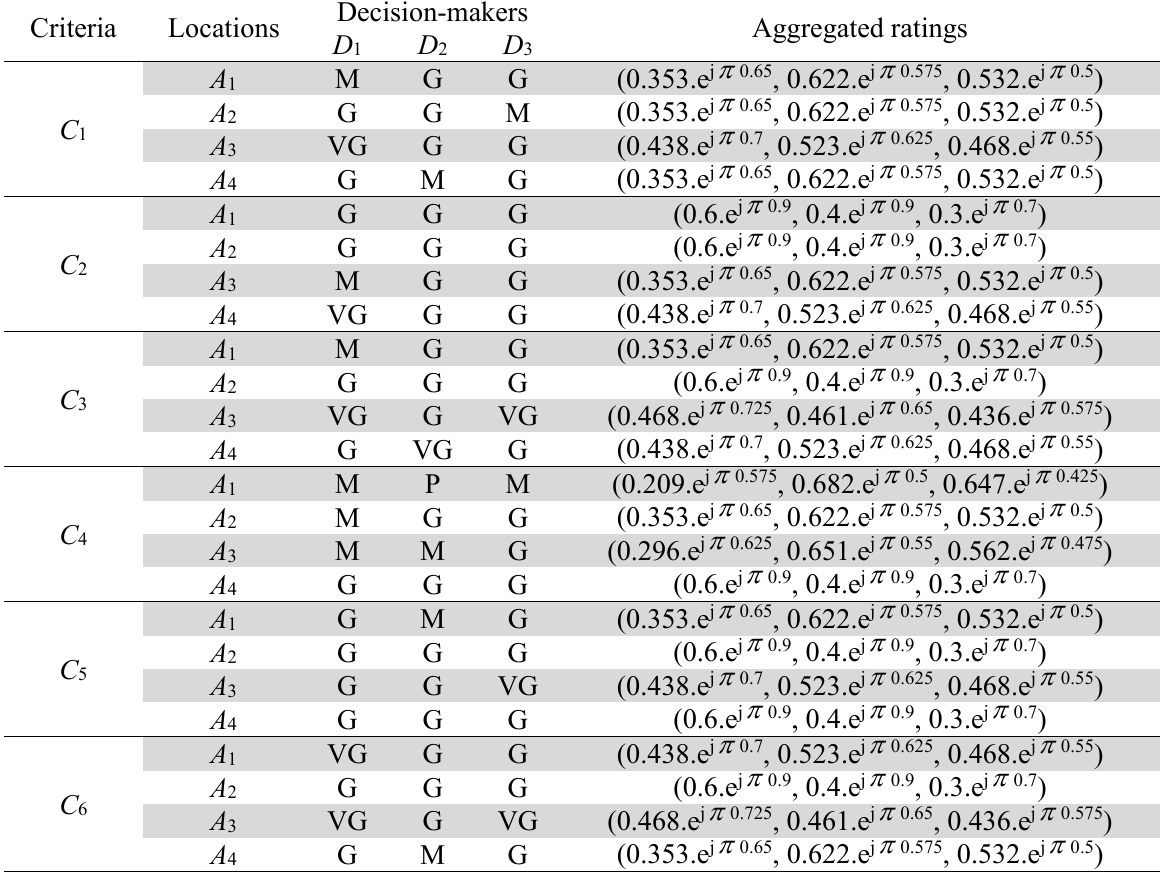
Table 1 Aggregated ratings of locations versus the criteria Criteria